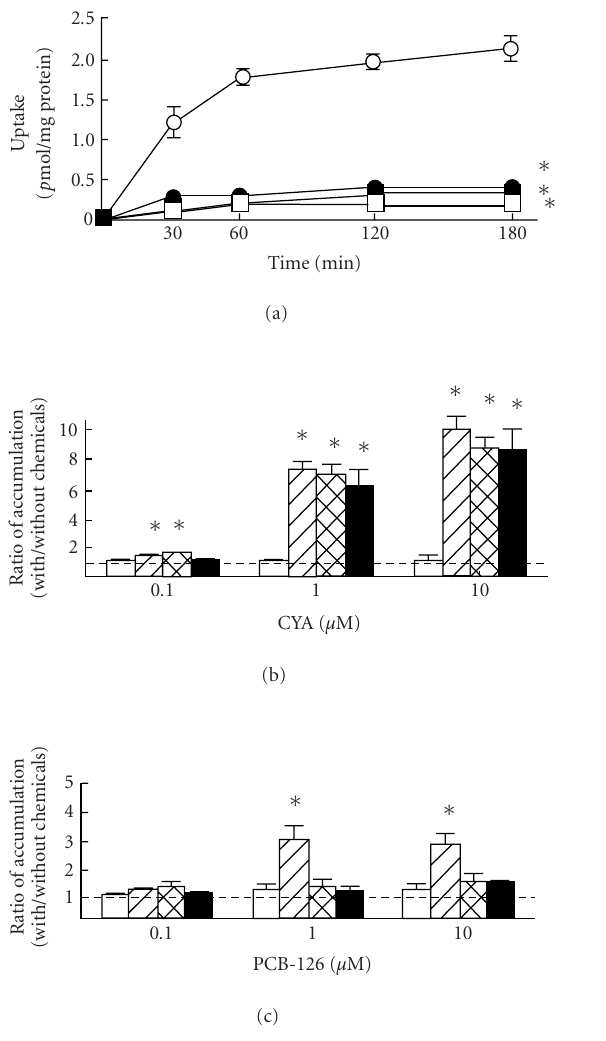
Figure 1. (a) Uptake of vinblastine in KB3-1 expressing with wild-type human P-glycoprotein (KB3-His 61 , filled circles), mu- tant P-glycoprotein in which His 61 was replaced with pheny- lalanine (KB3-Phe 61 , open squares) and serine (KB3-Ser 61 , filled squares), and transfected with transfection vector (KB3- Vec, open circles). (b) The ratios between the accumula- tions of vinblastine with and without cyclosporine A (CYA) and (c) PCB-126 (with/without CYA or PCB-126) in KB3- Vec (open columns), KB3-His 61 (cross-hatched columns), KB3- Phe 61 (hatched columns), and KB3-Ser 61 (filled columns). ∗ , P < . 05 compared to KB3-Vec. Means and SD of 4 experiments.